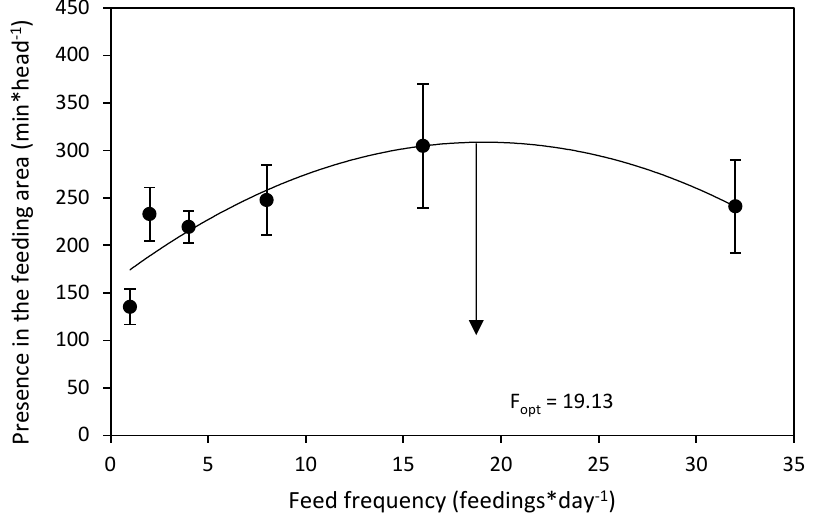
Figure 5. Effect of feed frequency on sum of Panulirus ornatus presence in the feeding area. The graph shows mean values ± S.E. The arrow shows optimal feed frequency (F opt ) for the highest sum of lobster presence in the feeding area.